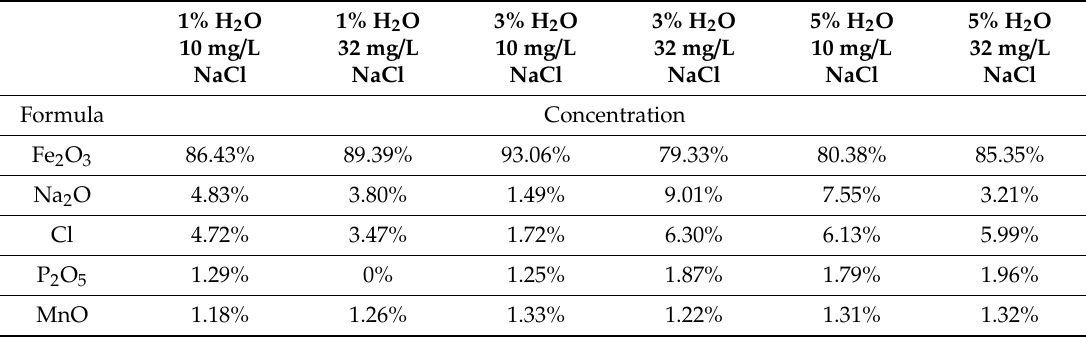
Table 8. X-ray fluorescence data.